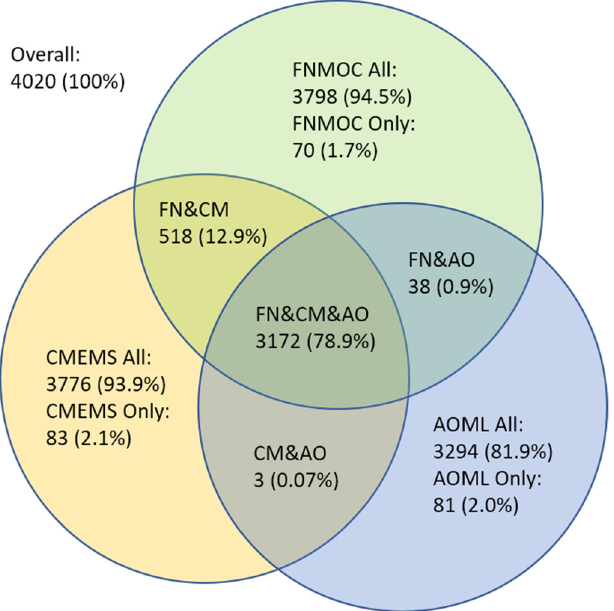
Figure 1. Distribution of drifters’ UIDs across the three data sets: FNMOC, CMEMS, and AOML. Spatial distributions of the UIDs shared by various pairs of the three data sets are shown in Figure 2. The 518 buoys shared by FNMOC and CMEMS (but not AOML) are shown in Figure 2a. They are spread around pretty much all over the global oceans, with the majority clustering in the North Atlantic Ocean, and some also found in the Indian and Pacific Oceans (particularly in the Kuroshio Current area). Quite some buoys are seen in the Arctic seas. The 38 UIDs shared between FNMOC and AOML (but not CMEMS) are shown in Figure 2b. Most of them are found around the Southeast Asia, from the Bay of Bengal to the South China Sea and the Kuroshio Current region. Finally, only three UIDs are shared by CMEMS and AOML (but not FNMOC), all in the eastern Mediterranean Sea (Figure 2c).